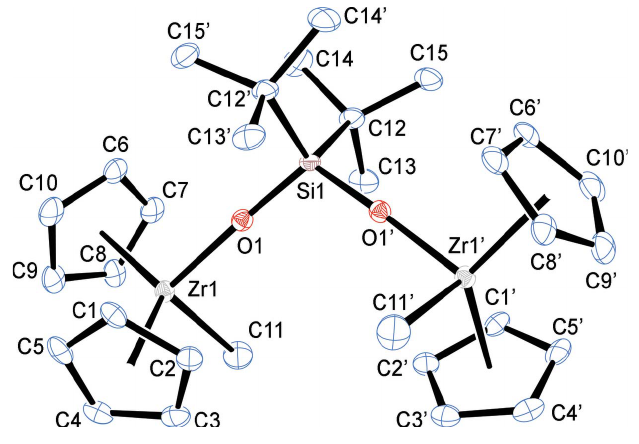
Figure 1 The molecular structure of 1 with displacement ellipsoids drawn at the 50% probability level; hydrogen atoms omitted for